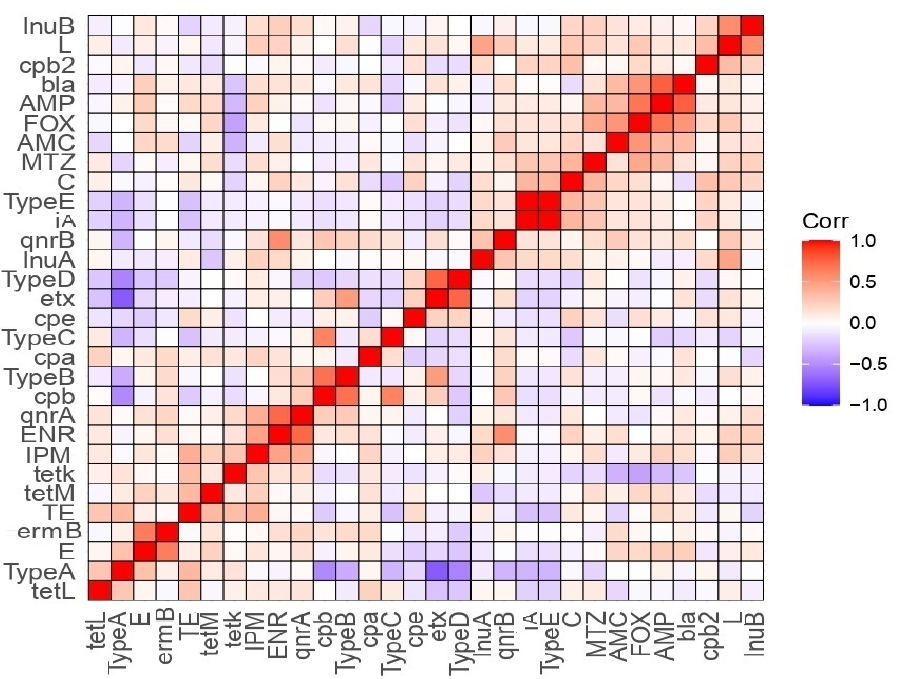
Figure 5. Correlation ( r ) between antimicrobial resistance, antibiotic resistance, and toxin genes and toxinotypes of C. perfringens isolates from different sample types. Red and blue colors indicate positive and negative correlations, respectively. The color key refers to correlation coefficient ( r ). The darker red and blue colors imply stronger positive (R= 0.5:1) and negative (R = −0.5:−1) correlations, respectively. AMP, ampicillin; AMC, amoxicillin/clavulanic acid; FOX, cefoxitin; ENR, enrofloxacin; IPM, imipenem; C, chloramphenicol; L, lincomycin; MTZ, metronidazole; E, erythromycin; TE, tetracycline. The tet(K) , tet(L) , and tet(M) ; lnu(A) and lnu(B) ; erm(B) ; bla ; and qnrA and qnrB are genes associated with tetracycline, lincomycin, erythromycin, β -lactams, and enrofloxacin resistances, respectively. The cpa, cpb, etx, ia, and cpe are C. perfringens alpha, beta, epsilon, iota, and enterotoxin genes, respectively, and cpb2 is the C. perfringens beta2 toxin gene.